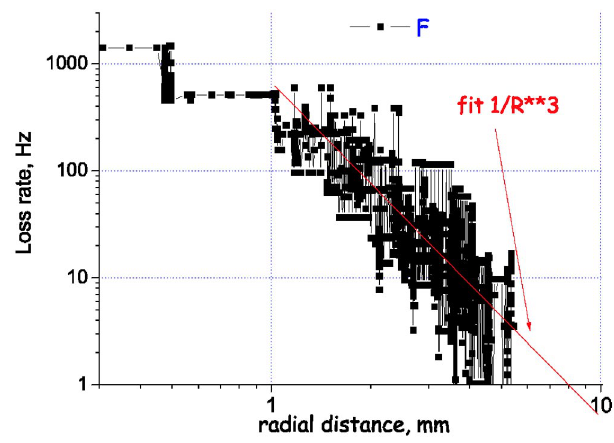
FIG. 86. (Color) Antiproton loss rate as a function of TEL distance, exhibiting an inverse cubic dependence (Shiltsev)